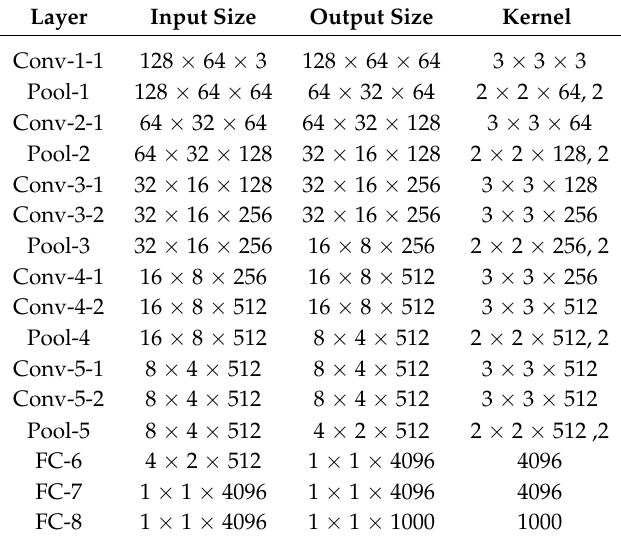
Table 1. Structure of the used VGG11-based model. The input and output sizes are described in # rows × # cols × # filters ; the kernel, in # rows × # cols × # filters , stride , or # outputs for FC